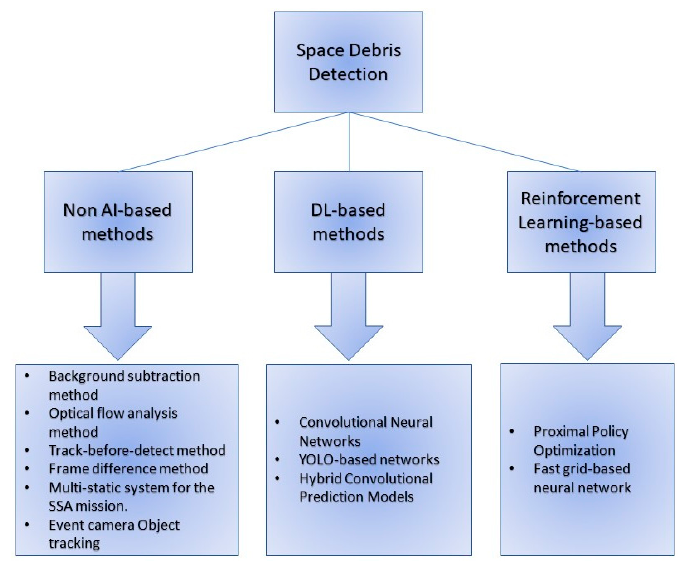
Figure 3. Space debris detection as a sub-group of SSA: enabling technologies.